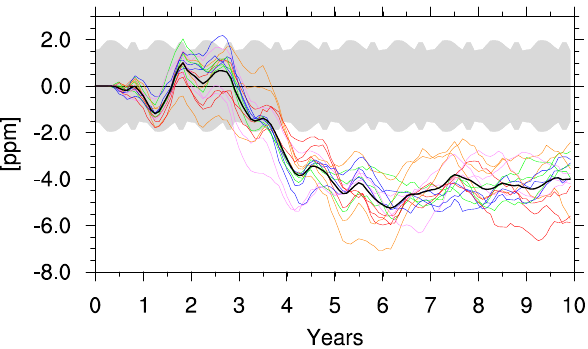
Fig. 11. Time series of monthly mean atmospheric p CO 2 anomaly in ppm for the first 10 years of the experiment for the ensemble mean (black line) and individual members (coloured lines and grey shaded area as in Fig.